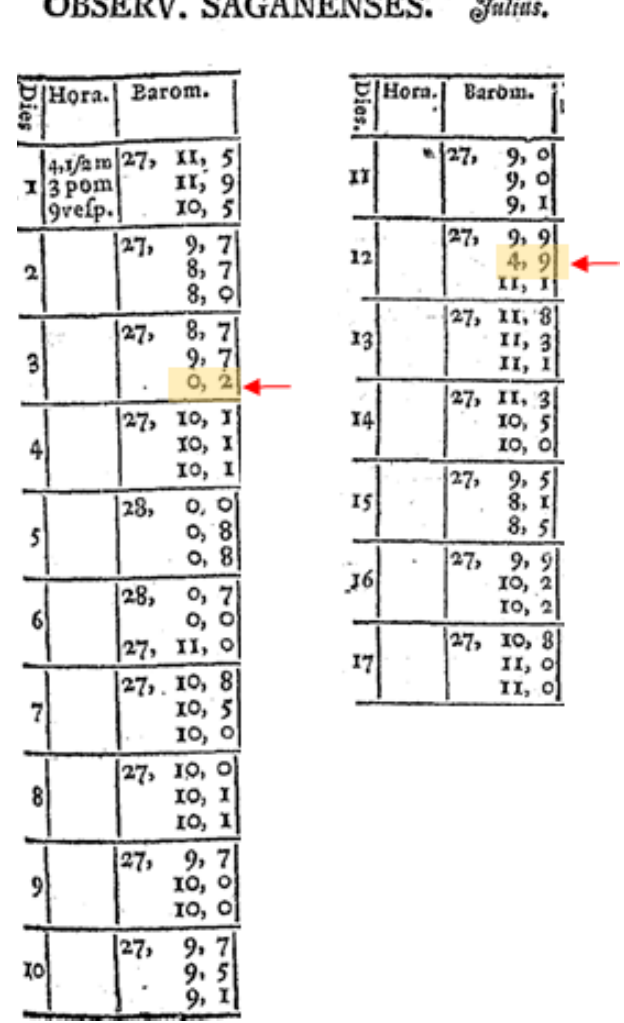
Figure 5. Barometer readings at ˙Zaga´n for 1–17 July 1781 (Ephemerides, 1795, 1783, pp. 373–374). The columns represent the days, observations times, and Paris inches and lines. The high- lighted values are likely printing errors and are flagged in the SEF file as wmo _ time _ consistency errors.